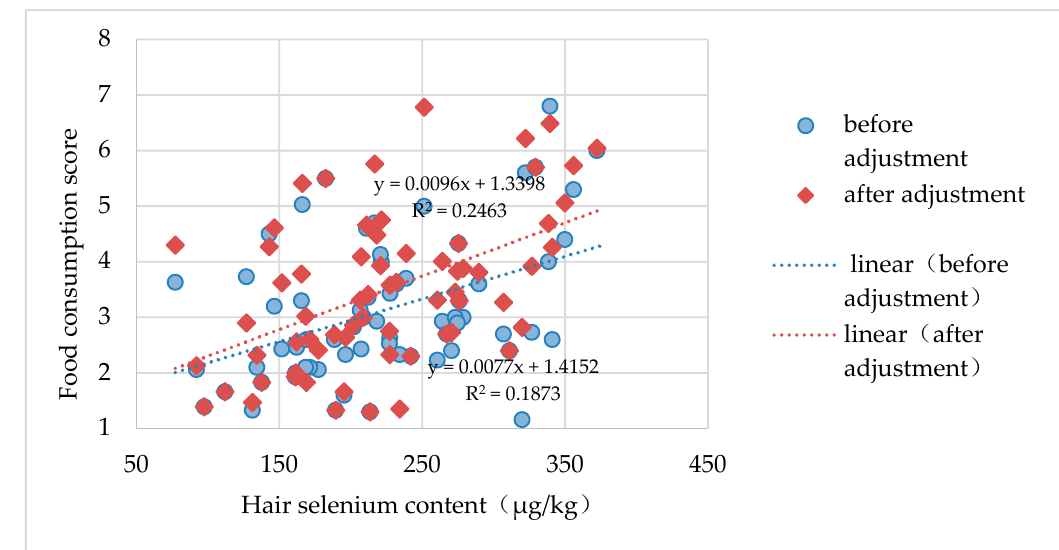
Figure 3. Scatter diagram of food consumption frequency score and hair selenium content ( μ g/kg).